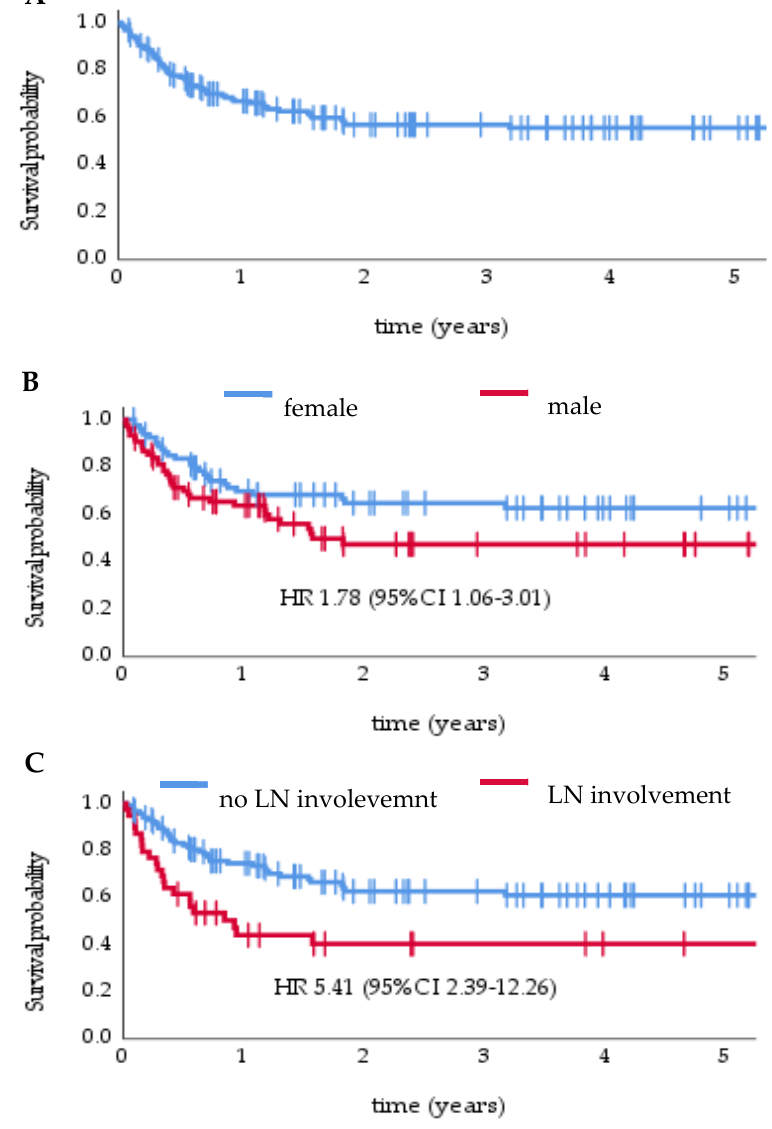
Figure 2. Disease-free survival in overall study population ( A ), stratified by gender ( B ) and lymph nodes (LN) involvement ( C ).